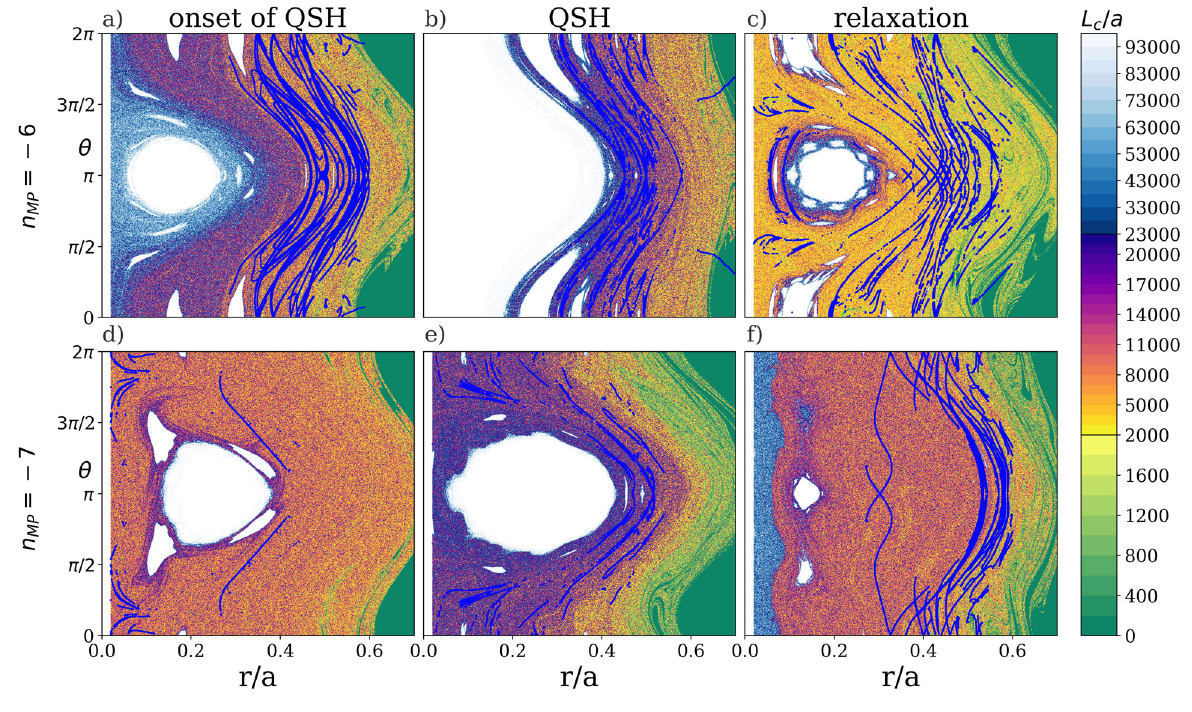
Figure 6. Blue Lagrangian Coherent Structures (LCS) are superimposed to the contour plot of connection length of magnetic field lines to the edge. LCS are common feature of quasi-helical regimes, and are typically found in bundles. White levels of the contour plot correspond to the regions where L c = L c , max = 10 5 . The blue LCSs divide regions with di ff erent connection length, highlighting their role in creating and internal barrier to the transport of magnetic field